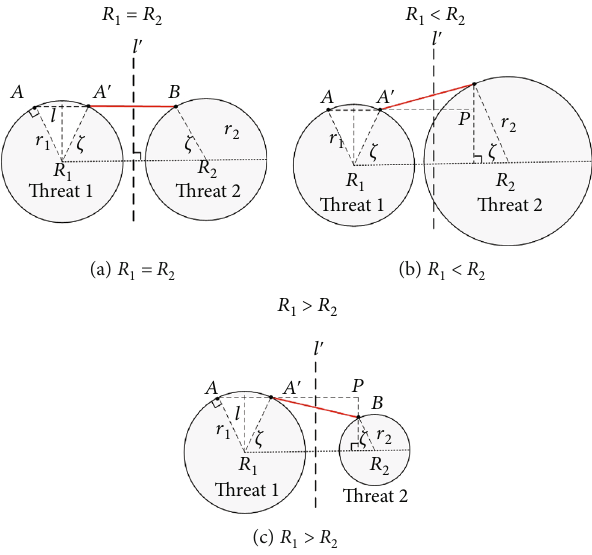
Figure 15: The boundary docking point of di ff erent associated threats.